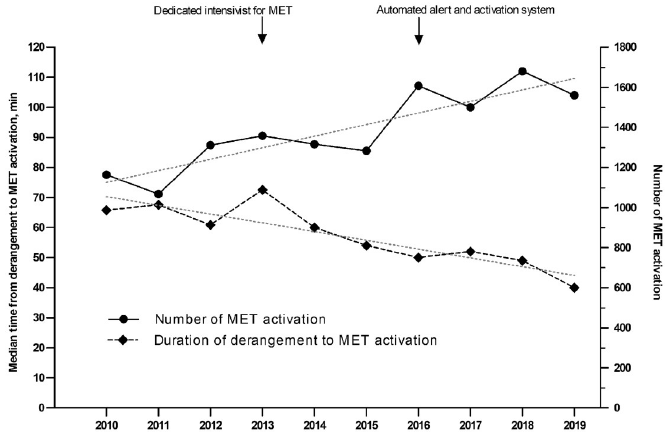
Fig 1. Medical emergency team (MET) maturation per year since 2010. The circles and lines represent of the number of MET activations. The number of MET activations increased from 1,164 in 2010 to 1,560 in 2019 (P for trend = 0.002). The diamonds and dotted lines represent the time from derangement to MET activation. The time from derangement to MET activation decreased from 66 minutes in 2010 to 40 minutes in 2019 (P for trend < 0.001). MET, medical emergency